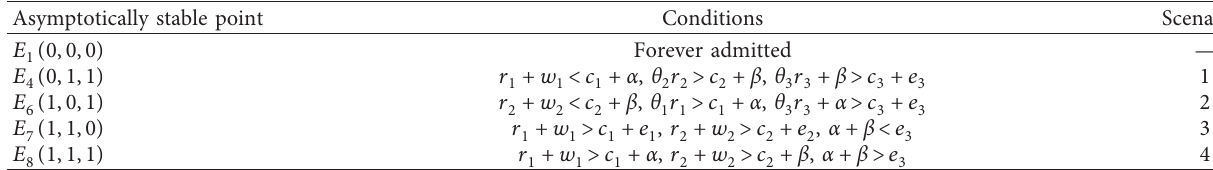
Table 4: Asymptotically stable point and its existence conditions.